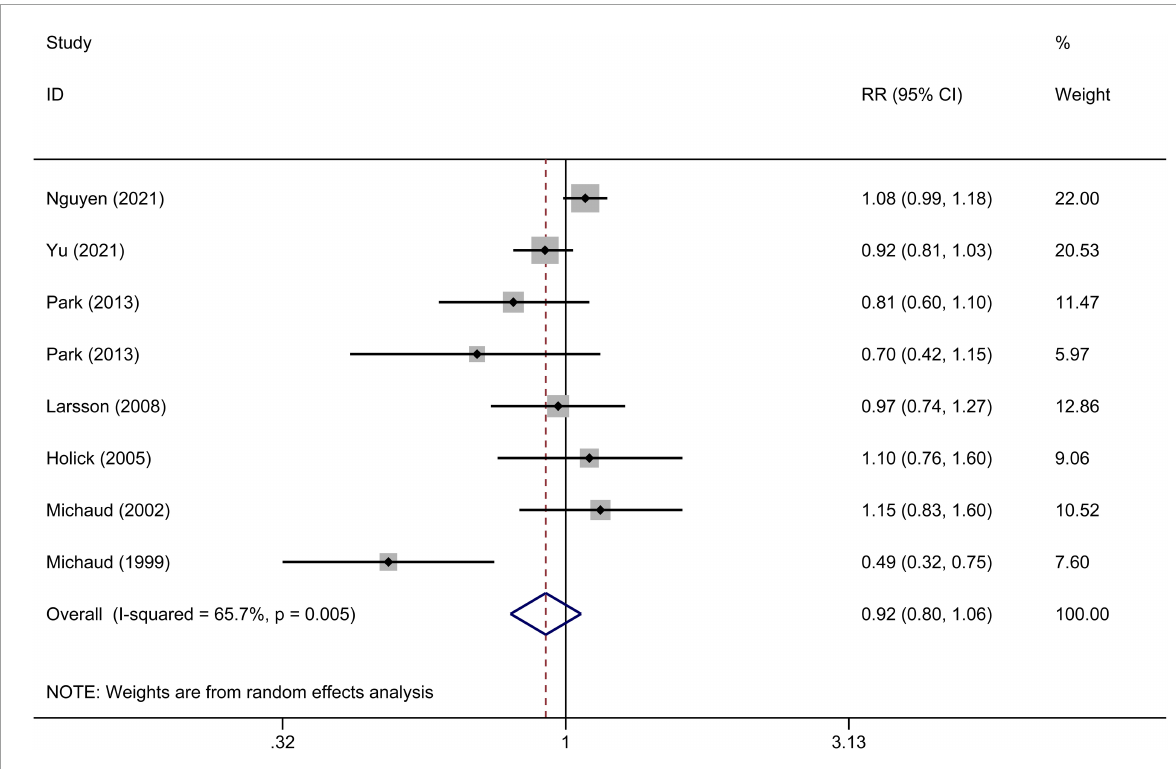
FIGURE2 A forest plot of pooled relative risks (RRs) for cruciferous vegetables intake and bladder cancer risk (the highest category compared with the lowest